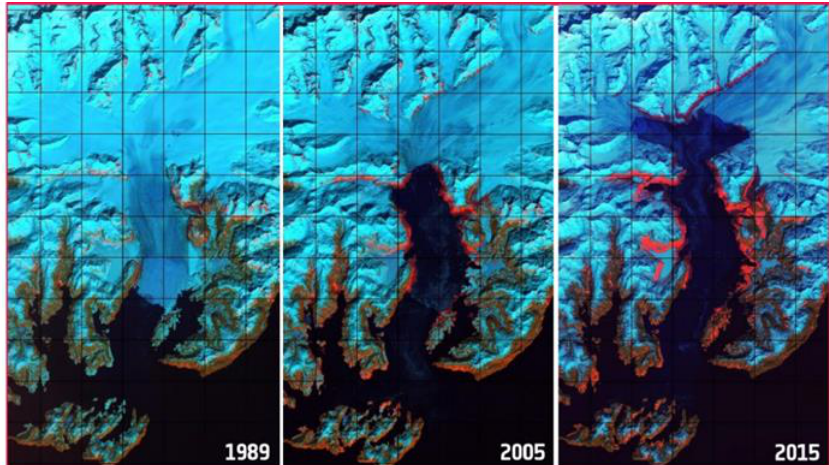
Figure 4. Satellite diachronic imagery of the Columbia glacier in Alaska. The image sequence was shown to the teachers to demonstrate the use of remote sensing for the calculation of the glacier’s shrinkage during a period of 26 years (taken from the ESA student activity “The ice is melting”, which is part of the “Teach with space” collection for the primary school level).